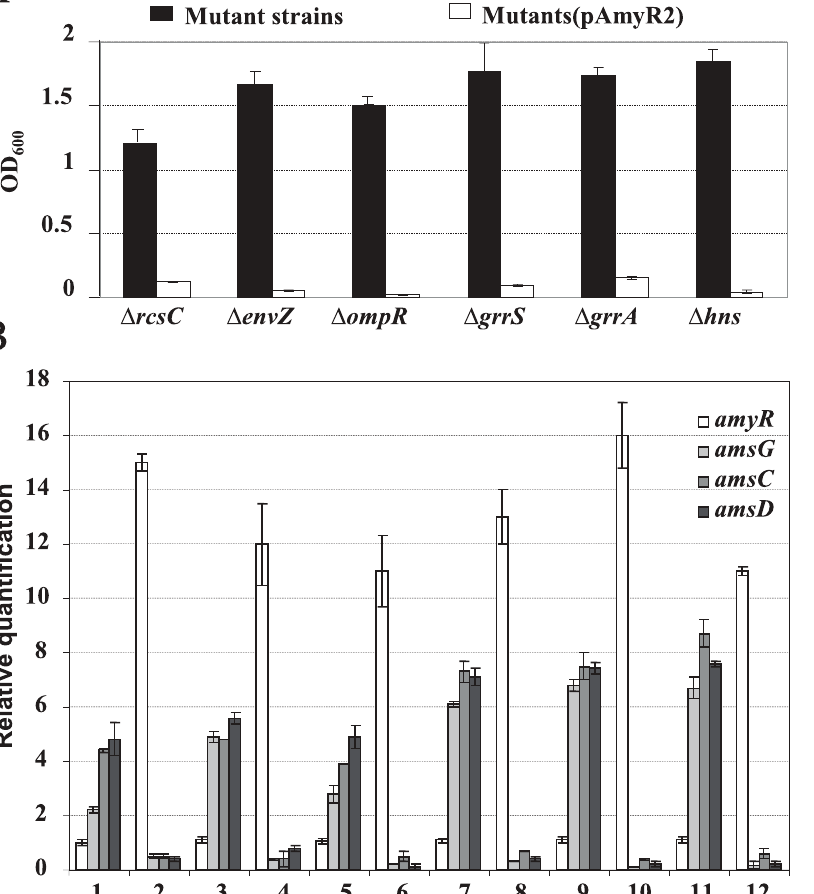
Figure 2. Over-expression of the amyR gene suppresses amylovoran production in various amylovoran over-producing mutants. A . Amylovoran production of various mutant strains with or without pAmyR2 plasmid. Bacterial strains were grown in MBMA media with 1% sorbitol for 24 hours at 28 u C with shaking. The amount of amylovoran was measured with the CPC assay and normalized to a cell density of 1. B . Relative quantification of amyR and amylovoran biosynthetic genes in various mutant strains with or without pAmyR2 plasmid by qRT-PCR. Bacterial strains were grown in MBMA media with 1% sorbitol for 18 hours at 28 u C with shaking. 1: D rcsC , 2: D rcsC (pAmyR2), 3: D envZ , 4: D envZ (pAmyR2), 5: D ompR , 6: D ompR (pAmyR2), 7: D grrS , 8: D grrS (pAmyR2), 9: D grrA , 10: D grrA (pAmyR2), 11: D hns , 12: D hns